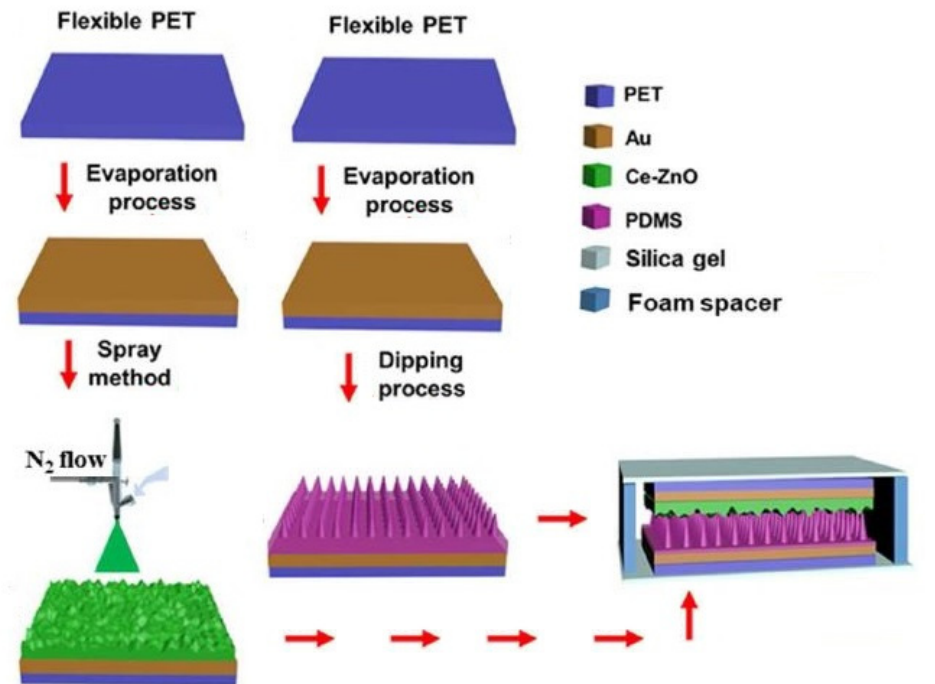
Figure 5. Illustration of the fabrication steps of the PET/PDMS/Silica gel/Ce-ZnO-based wearable respiration sensors [136].